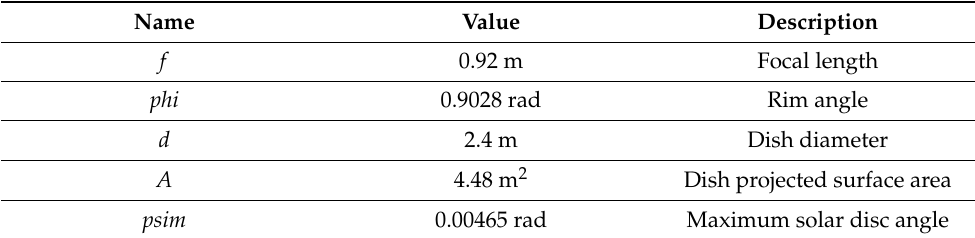
Table 1. Parameters of the solar dish concentrator.